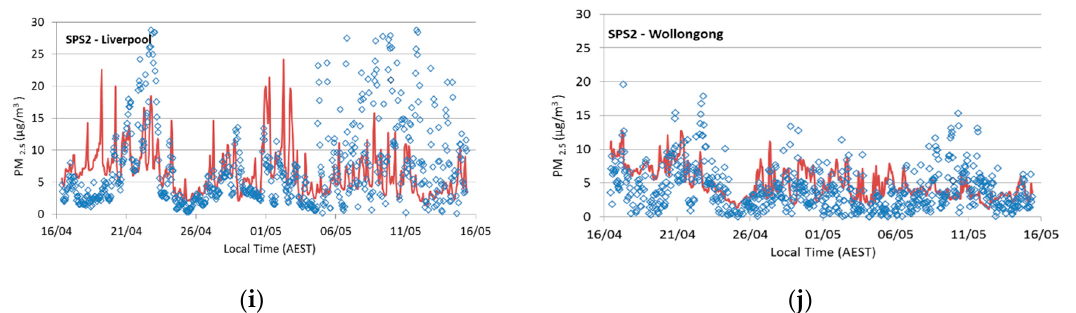
Figure 7. The time series of predicted (red line) and observed (blue hollow dot) hourly PM 2.5 concentrations ( μ g/m 3 ) at Chullora, Earlwood, Richmond, Liverpool and Wollongong stations for: SPS1 ( a – e ); and SPS2 ( f – j ).